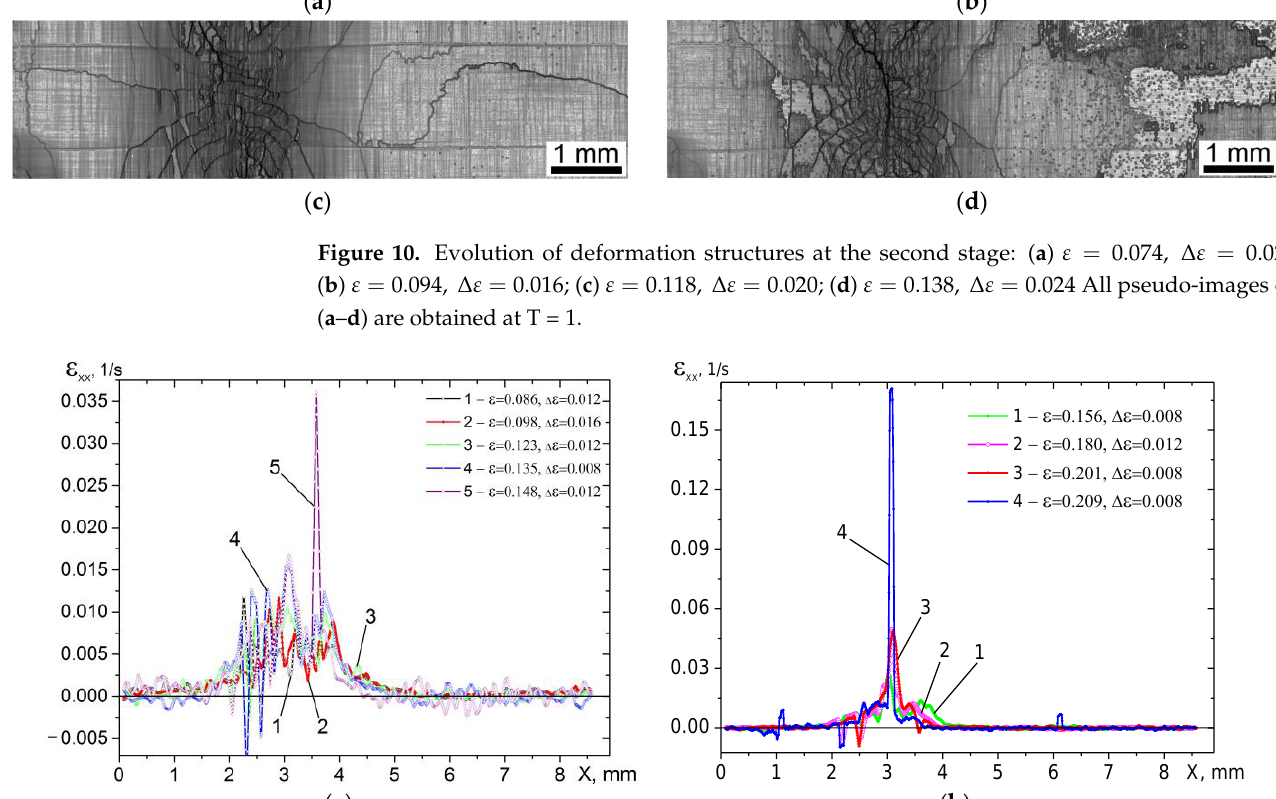
Figure 11. Spatial distribution of longitudinal strain at the second ( a ) and third ( b ) stages.